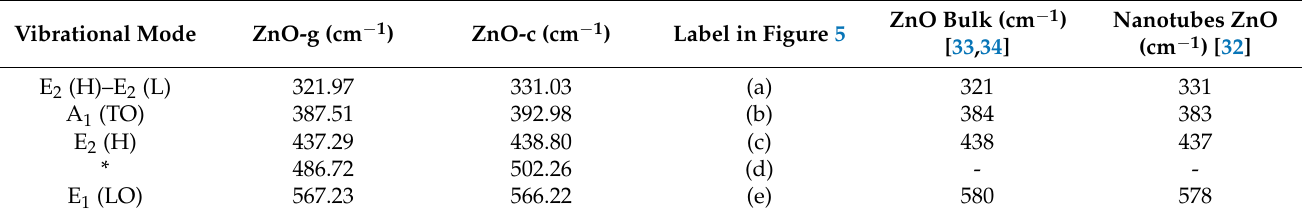
Table 1. Comparison of Raman shift values for vibrational modes between the as ‐ oxidized ZnO structures previously etched with 2 M (ZnO ‐ g) and 8 M (ZnO ‐ c) HNO 3 solutions. Note that * point a vibrational mode not reported for ZnO.